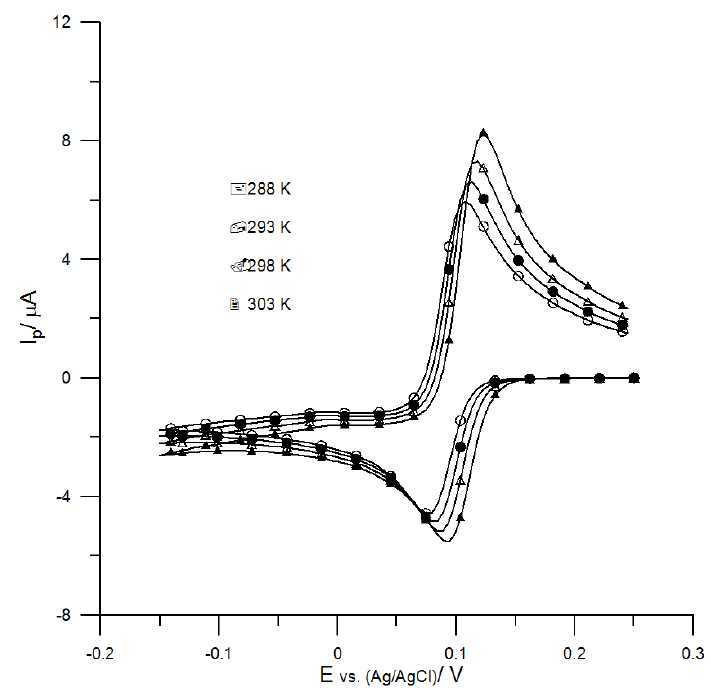
Figure 3. Cyclic voltammetric curves for the Bi(III)/Bi(Hg) system in 5 mol dm -3 chlorate (VII) in the presence of 10 -2 mol dm -3 cystine at scan rate of 100 mV s -1 , in the studied temperature range: ( ○ ) 288 K, ( ● ) 293 K, ( D ) 298 K, ( ▲ ) 303